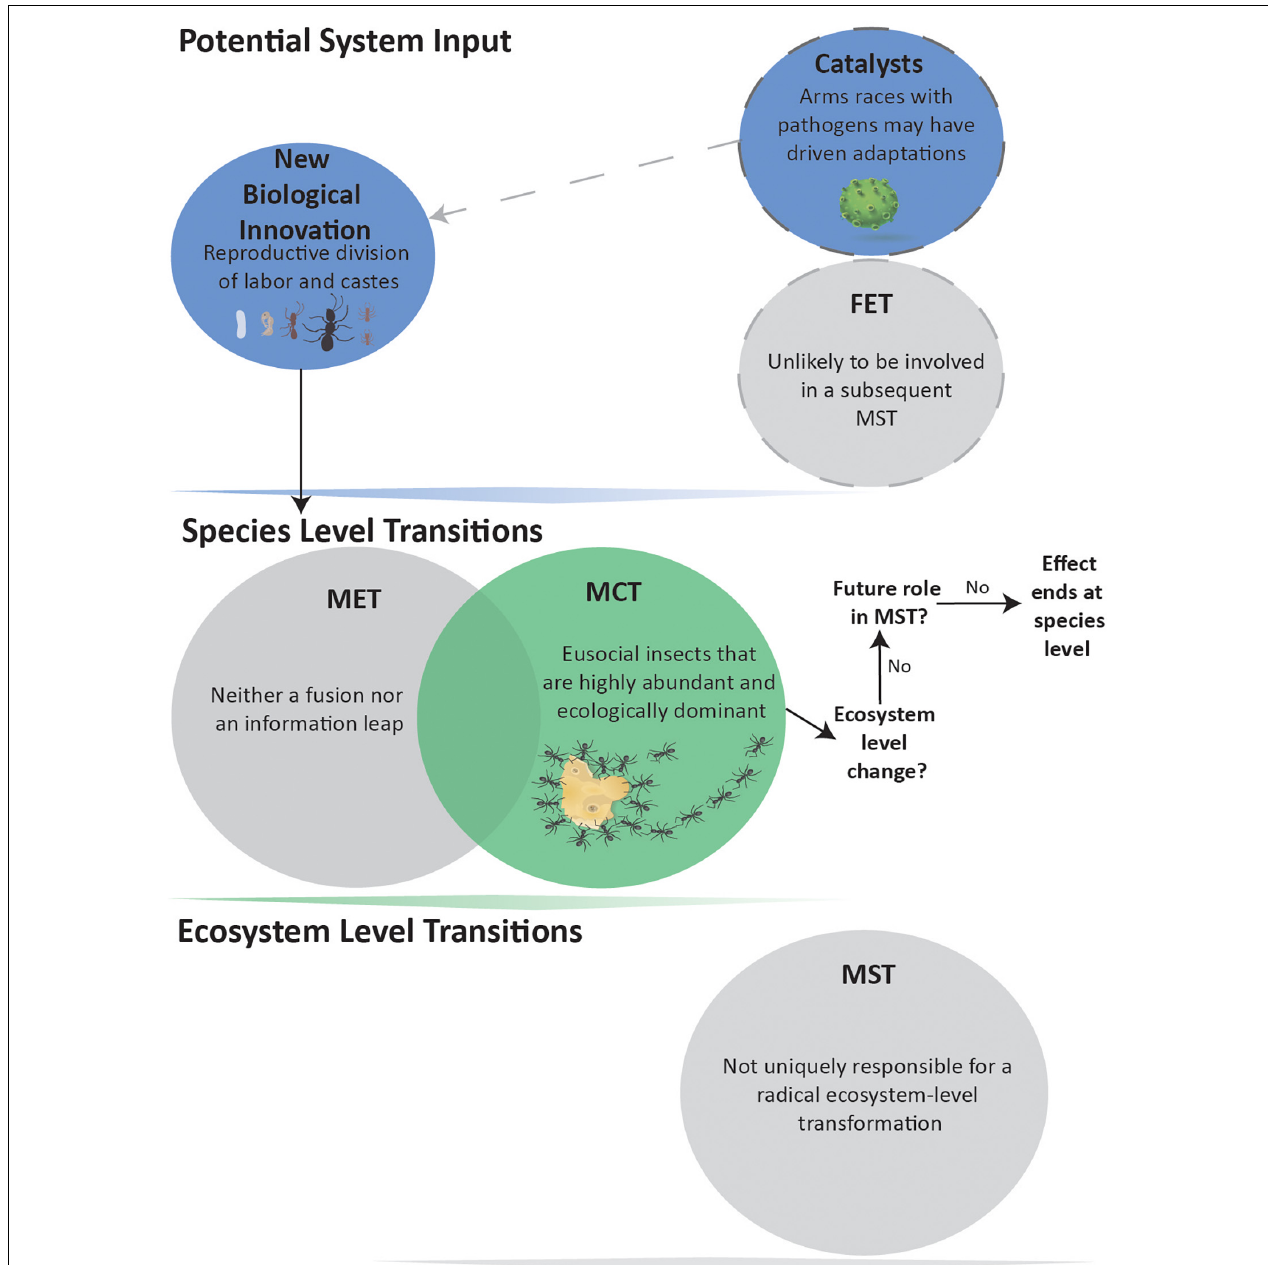
FIGURE 3 | Eusocial evolution not leading to a MST. Evolution of morphologically distinct castes and reproductive division of labor is considered a MCT due to the abundance of social insects. These biological innovations are neither Fusions nor Information Leaps and, therefore, not a MET. The eusocial insect MCT has arguably not produced an Ecosystem-level MST, and shows no indication for being a FET in any such impending